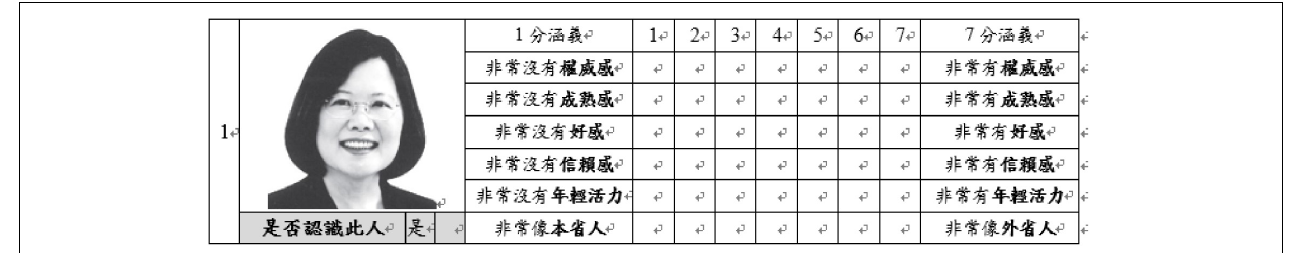
FIGURE 4 | A practice question of the trait rating task questionnaire in Experiment 2. Photo shown is the current Taiwanese president, Ing-Wen Tsai, whose photo was not included in the actual rating task (The photo was obtained from the 2012 Taiwanese President Election by the Central Election Commission website). The question below the candidate’s photo is “Do you recognize this person?”. The table on the right side of the candidate’s photo lists the six-trait rating questions on the 7-point scale (from top to bottom: Dominance, Facial Maturity, Likeability, Trustworthiness, Youthfulness, and Provincial Appearance